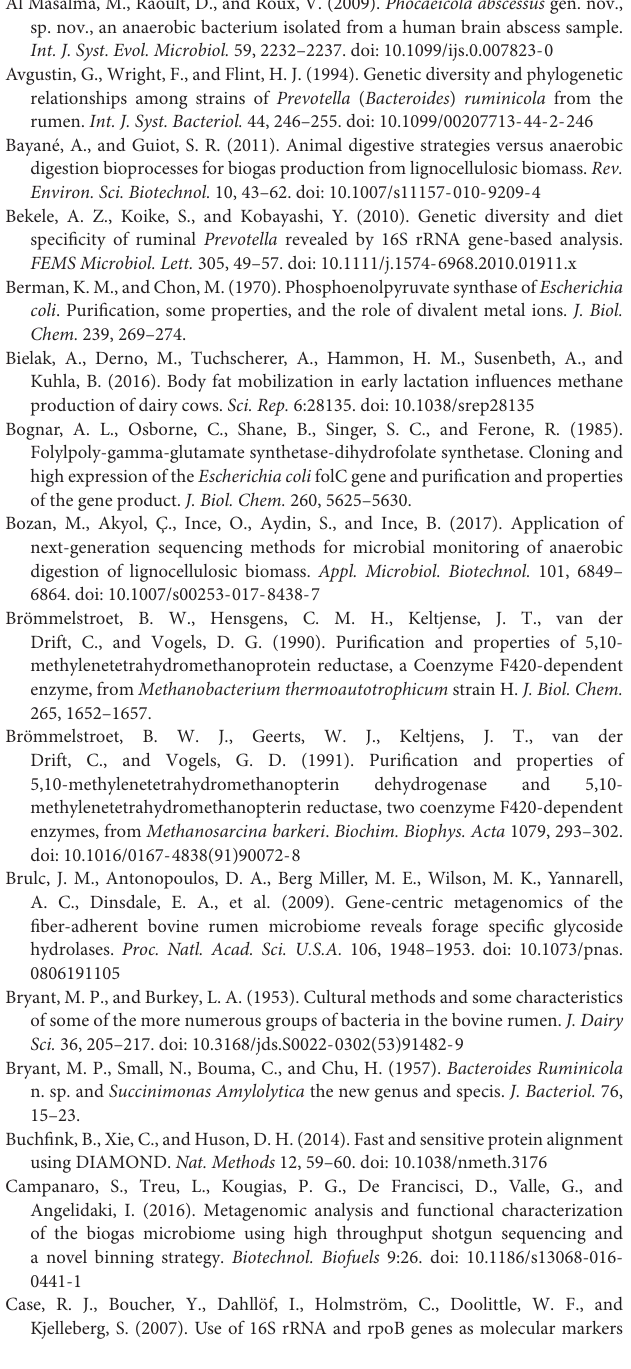
FIGURE S7 | Co-occurrence analysis of the metatranscriptome (RNA) samples. Enlargement of the picture shows the function belonging to the colored dot in the network. Functions identified in the core of all ten rumen samples were included in the calculation. TABLE S1 | Composition of feed received by the cows involved in this study.